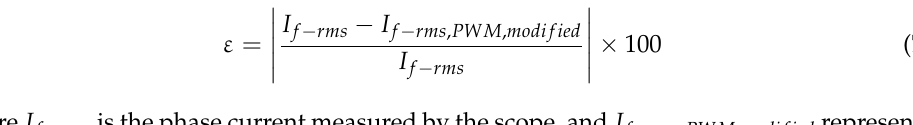
Figure 22. Single-shunt reconstruction of a three-phase current with SVM modification for f = 75 Hz: ( a ) m i = 0.4; ( c ) m i = 0.6; ( e ) m i = 0.8; scope-measured real three-phase currents for f = 75 Hz: ( b ) m i = 0.4; ( d ) m i = 0.6; ( f ) m i = 0.8.